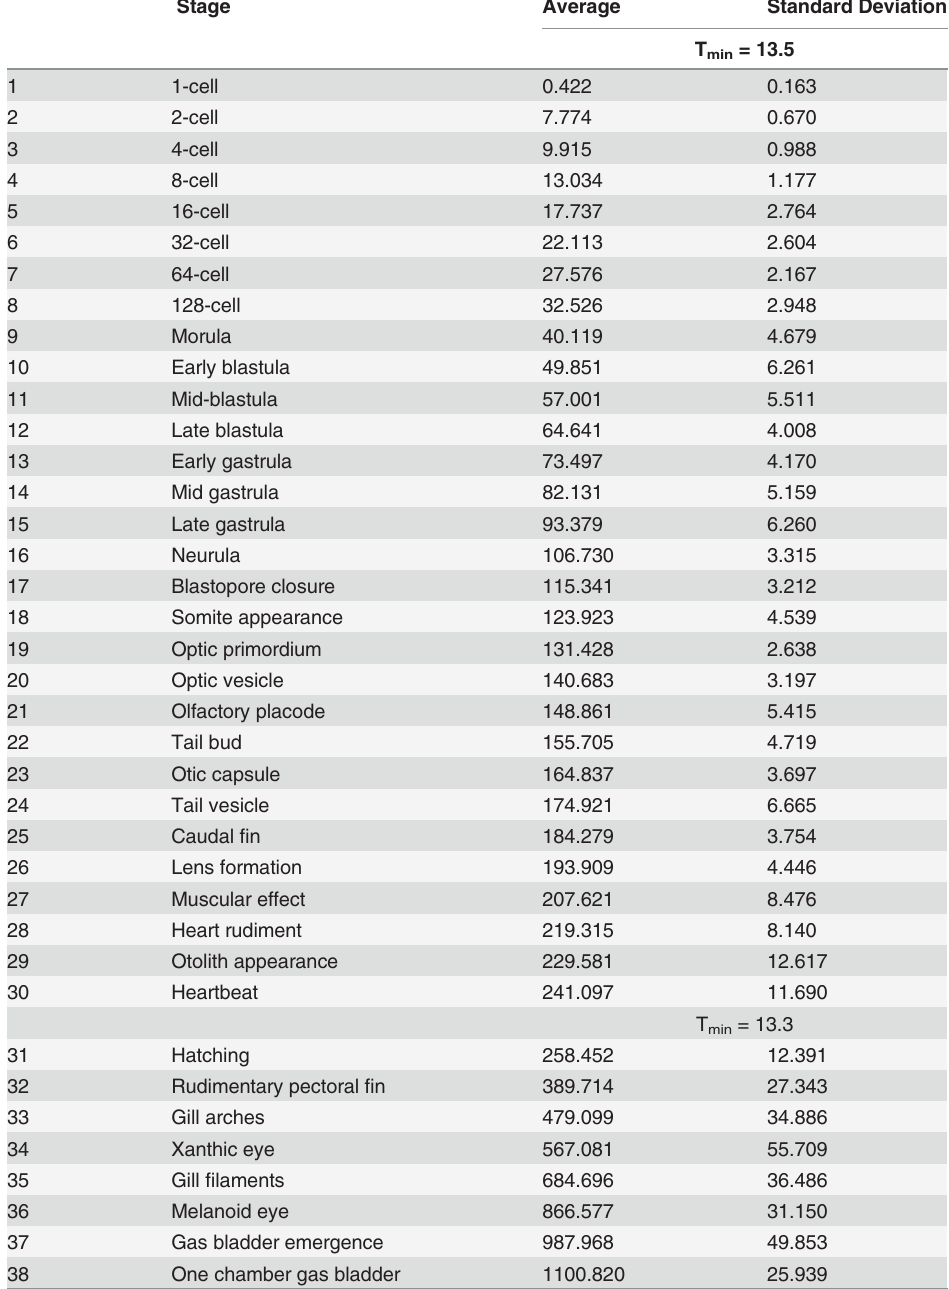
Table 1. Cumulative thermal units (CTU) for grass carp development at various stages. T min is given separately for embryonic and larval stages.